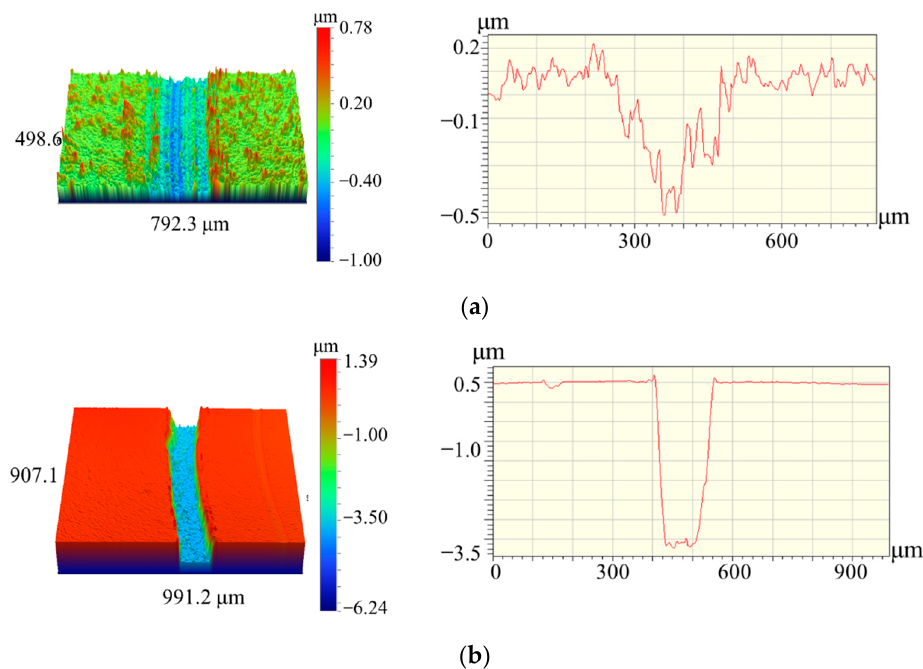
Figure 7. Three-dimensional (3D) and 2D images of the wear tracks for Coatings 1 ( a ) and 2 ( b ). The wear rate of the 1A coating was 4.2 × 10 − 7 mm 3 N − 1 m − 1 . Importantly, the wear track depth of the nonreactive coating was 0.4 µ m, which did not exceed the total coating’s track depth was ~4 µ m at the coating’s thickness of 3.7 µ